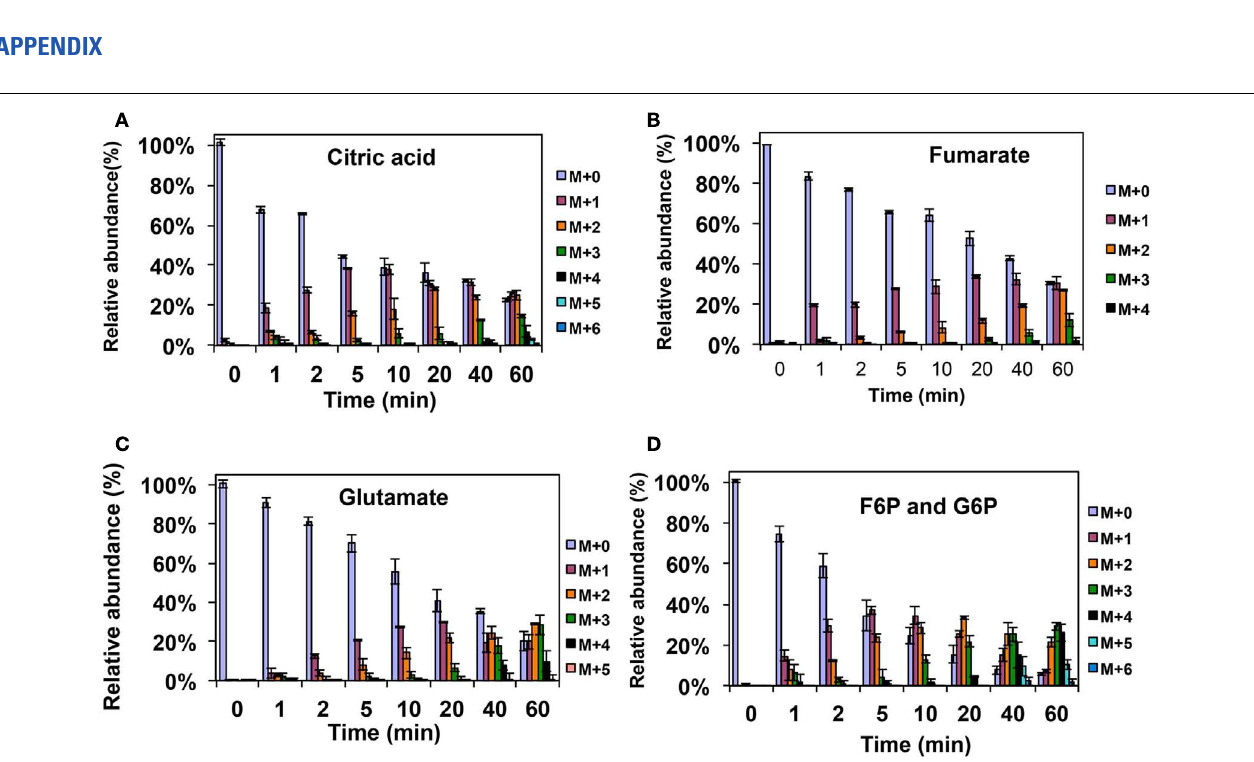
FIGUREA1 | 13 C-incorporation during the switch from 12 CH 4 to 13 CH 4 in Methylosinus trichosporium OB3b . (A) 12 C/ 13 C-isotopomer distributions of citric acid (A) , fumarate (B) , glutamate (C) , and fructose-6-phosphate/glucose-6-phosphate (D) .